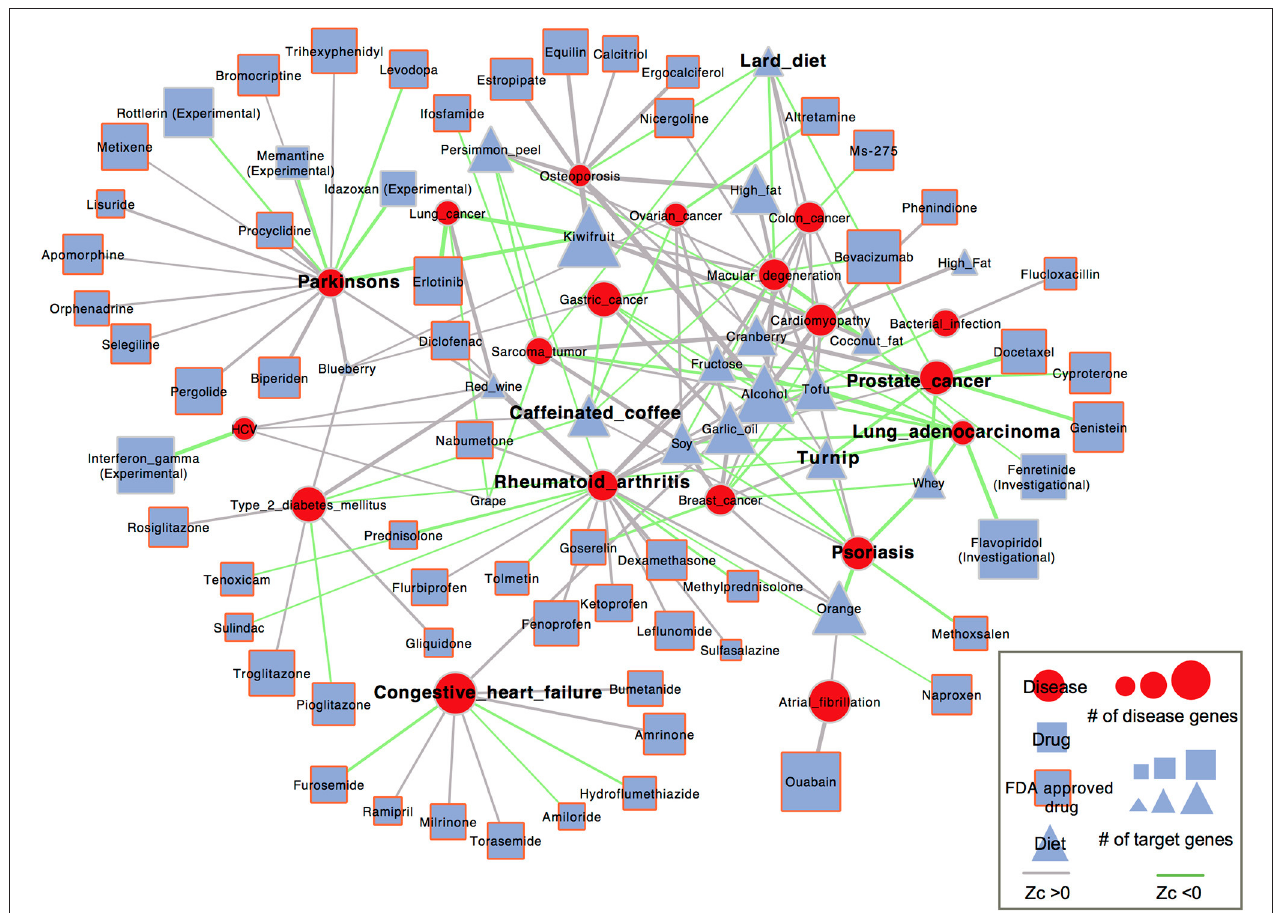
FIGURE 6 | Network-based diet-disease and drug-disease proximity. Nodes represent diseases (red circle), diet (blue square) or drug (blue triangle). Blue triangle with red border represents FDA approved drugs. The node size scales with the number of disease genes and the number of DE genes of diet and drug. Diets (or drugs) and diseases are linked by anti-correlated relationships between them. The link color represents whether the diet (or drug) is proximal (Z c < 0, green) or distant (Z c < 0, gray) to the disease. The edge thickness is proportional to the absolute value of the proximity